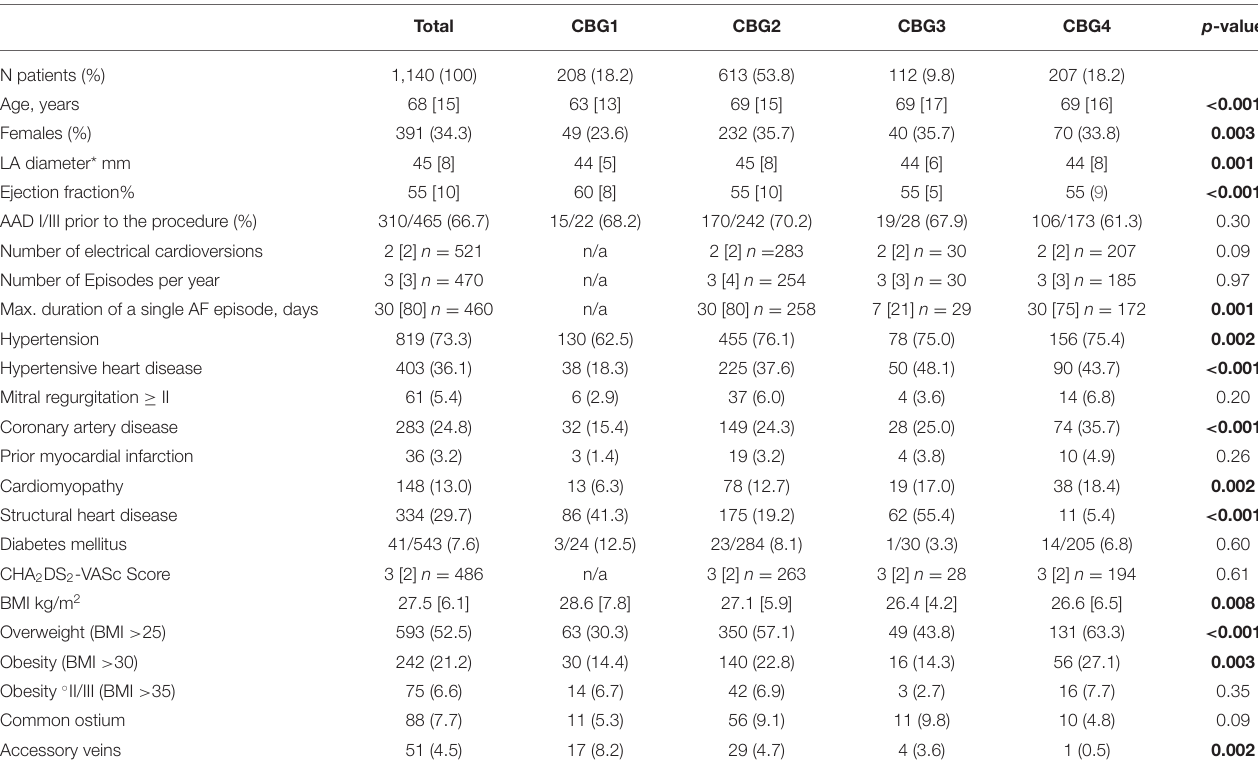
TABLE 1 | Baseline characteristics and differences in the treatment groups. Total CBG1 CBG2 CBG3 CBG4 p